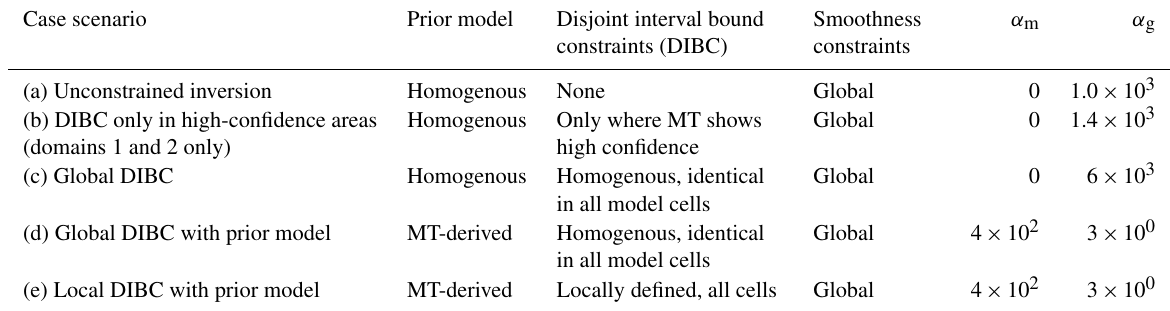
Table 2. Scenarios tested for the utilisation of MT-derived information in magnetic data inversion. “High confidence” refers to the case where constraints are applied only to models cells with MT-derived rock unit probabilities equal to 1.